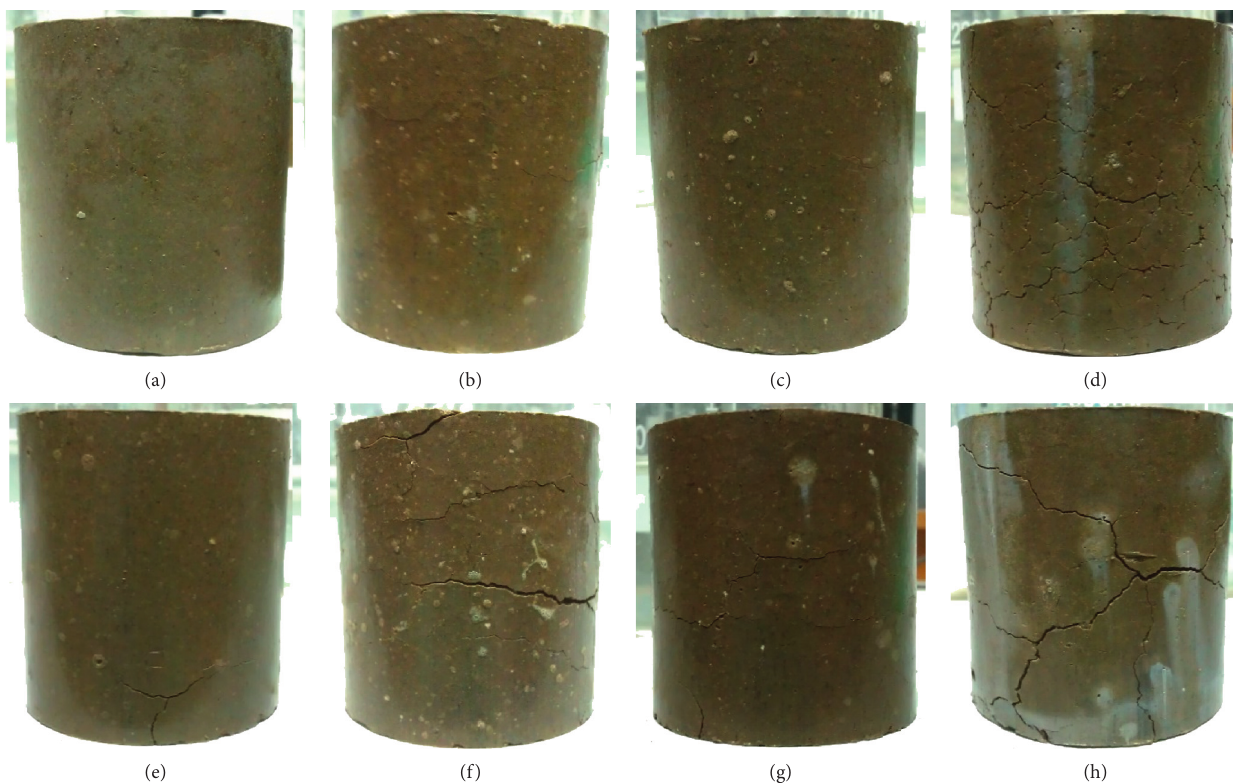
Figure 6: Photos showing the cracks developed on the surfaces of the stabilized soils after water-soaking tests (curing time of 27d and binder content of 6%). (a) KMP Zn0Pb0. (b) KMP Zn1.5. (c) KMP Pb2. (d) KMP Zn1.5Pb2. (e) PC Zn0Pb0. (f) PC Zn1.5. (g) PC Pb2. (h) PC Zn1.5Pb2.